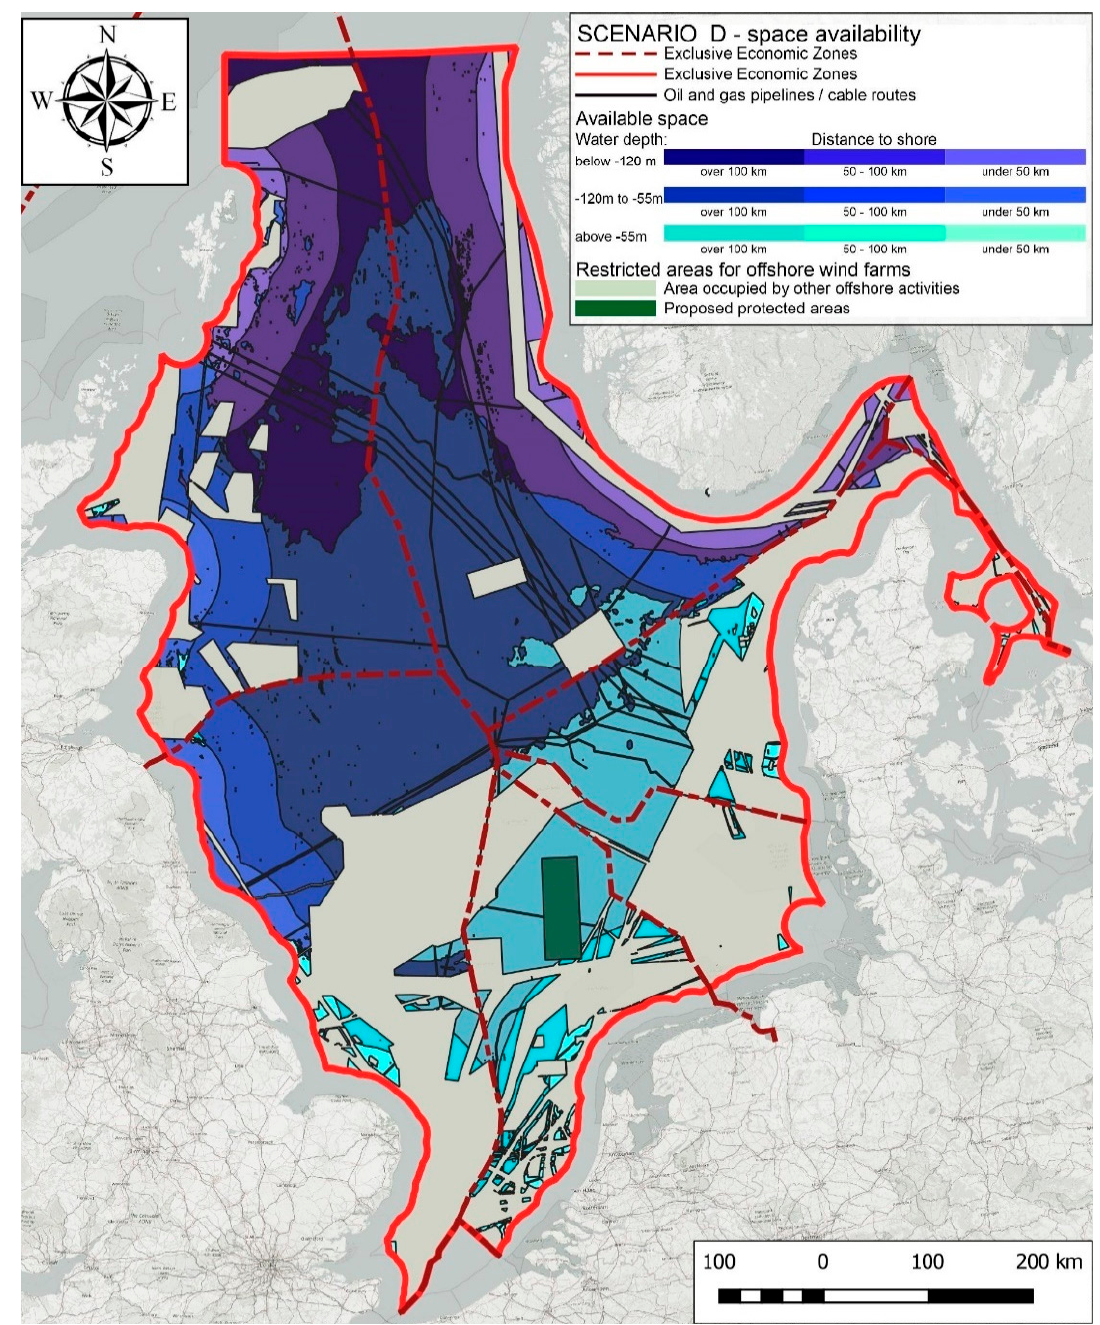
Figure 10. Scenario D: High renewable energy ambitions/sectoral planning.